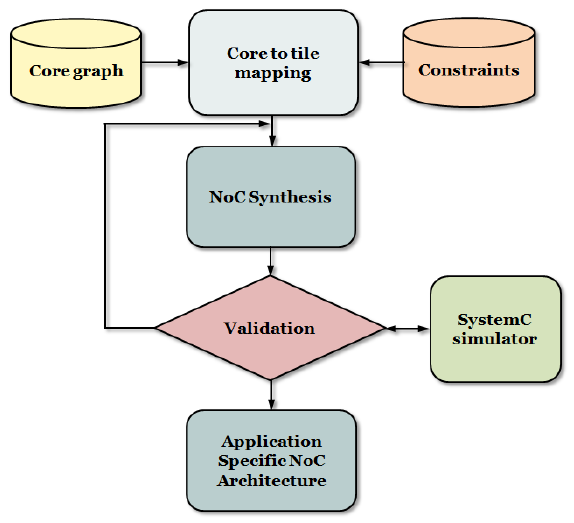
Figure 2. NoC synthesis design flow of the synthesis process.